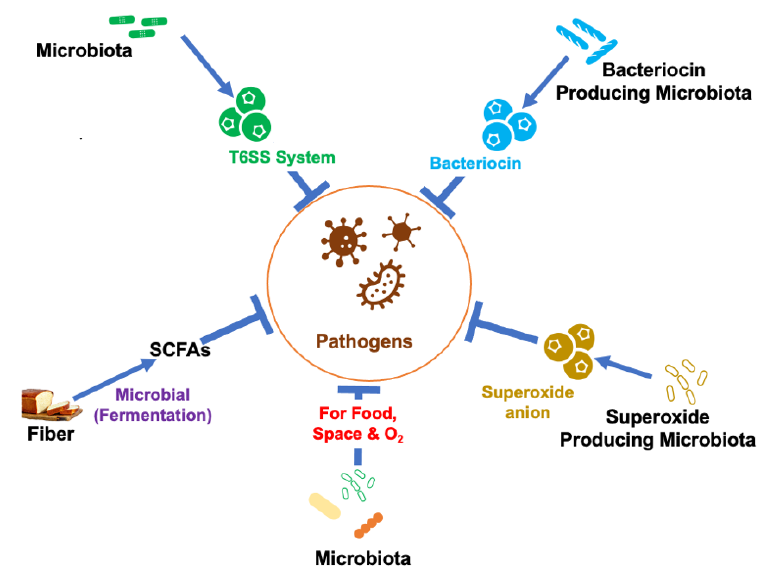
Figure 1. Mechanisms used by the gut bacteria in host defense. The gut microbiota modulates pathogenic bacterial overgrowth by producing antimicrobial peptides (bacteriocin), T6SS toxic protein, SCFAs, superoxide ion, and competing for food space and oxygen, which protects the host and maintains GI homeostasis. SCFAs: Short-chain fatty acids; O 2 : oxygen